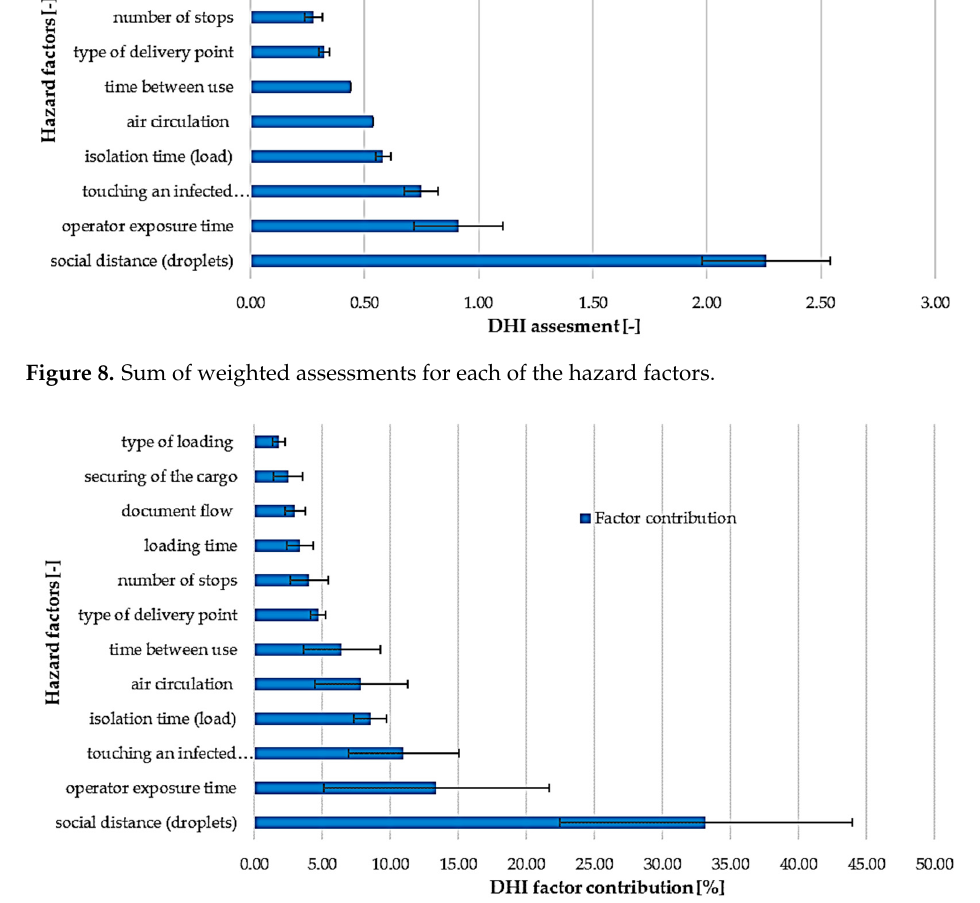
Figure 9. Contribution of the sum of weighted assessments for each of the hazard factors.